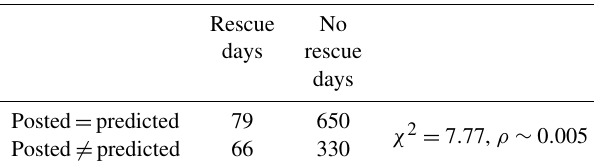
Table 1. Results of χ 2 analysis of posted and predicted flag colour versus rescue and no rescue days at Pensacola Beach, Florida, be- tween 2004 and